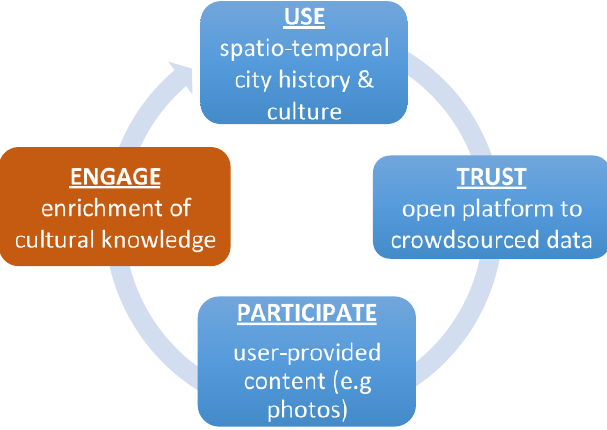
Figure 11. City-Stories life cycle.